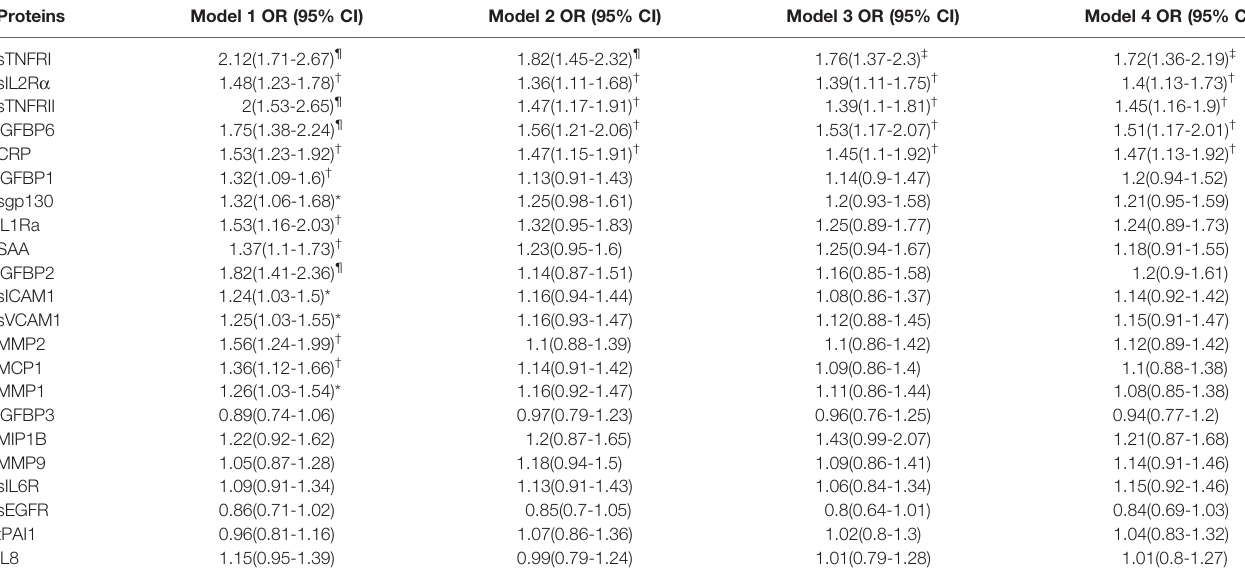
TABLE 2 | DPN is independently associated with per SD increase in serum levels, after adjusting for age at sample, duration of T1D, Gender, glycemic control, hypertension and dyslipidemia. Proteins Model 1 OR (95%